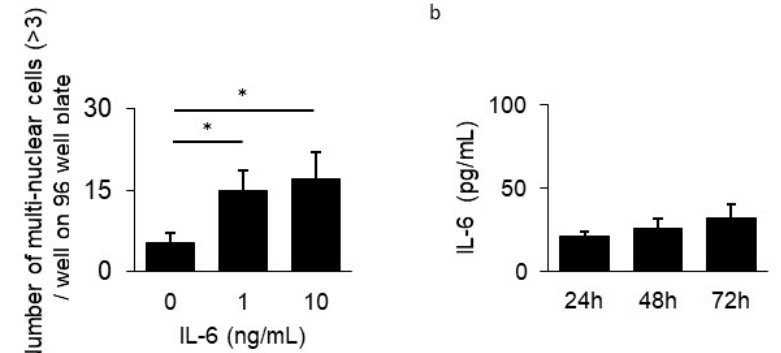
Figure 5. Effect of IL-6 on osteoclast differentiation. ( a ) Osteoclast differentiation assay was performed in the presence of sRANKL (100 ng/mL), M-CSF (20 ng/mL), and IL-6 (0, 1, 10 ng/mL) for 7 days ( d ). Osteoclasts with multiple nuclei (>3) in 96-well plates were counted after TRAP-staining. ( b ) IL-6 production in the supernatant of BMMCs in the presence of sRANKL (100 ng/mL) and M-CSF (20 ng/mL) after 24, 48, and 72 h was measured using ELISA. The data represent the results of three independent experiments. * Significantly larger number of osteoclasts by Student’s t -test (* p < 0.01).